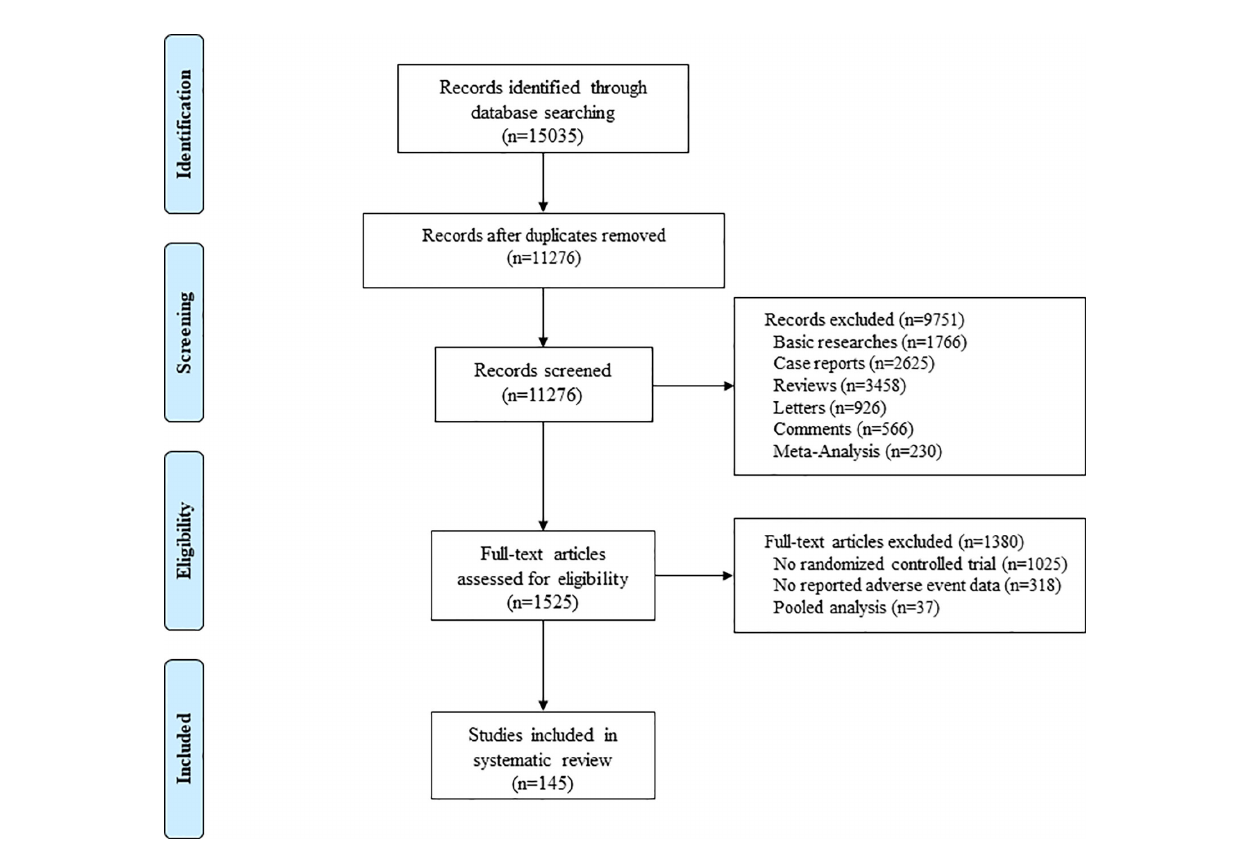
FIGURE 1 | Flow Diagram of the Study Selection